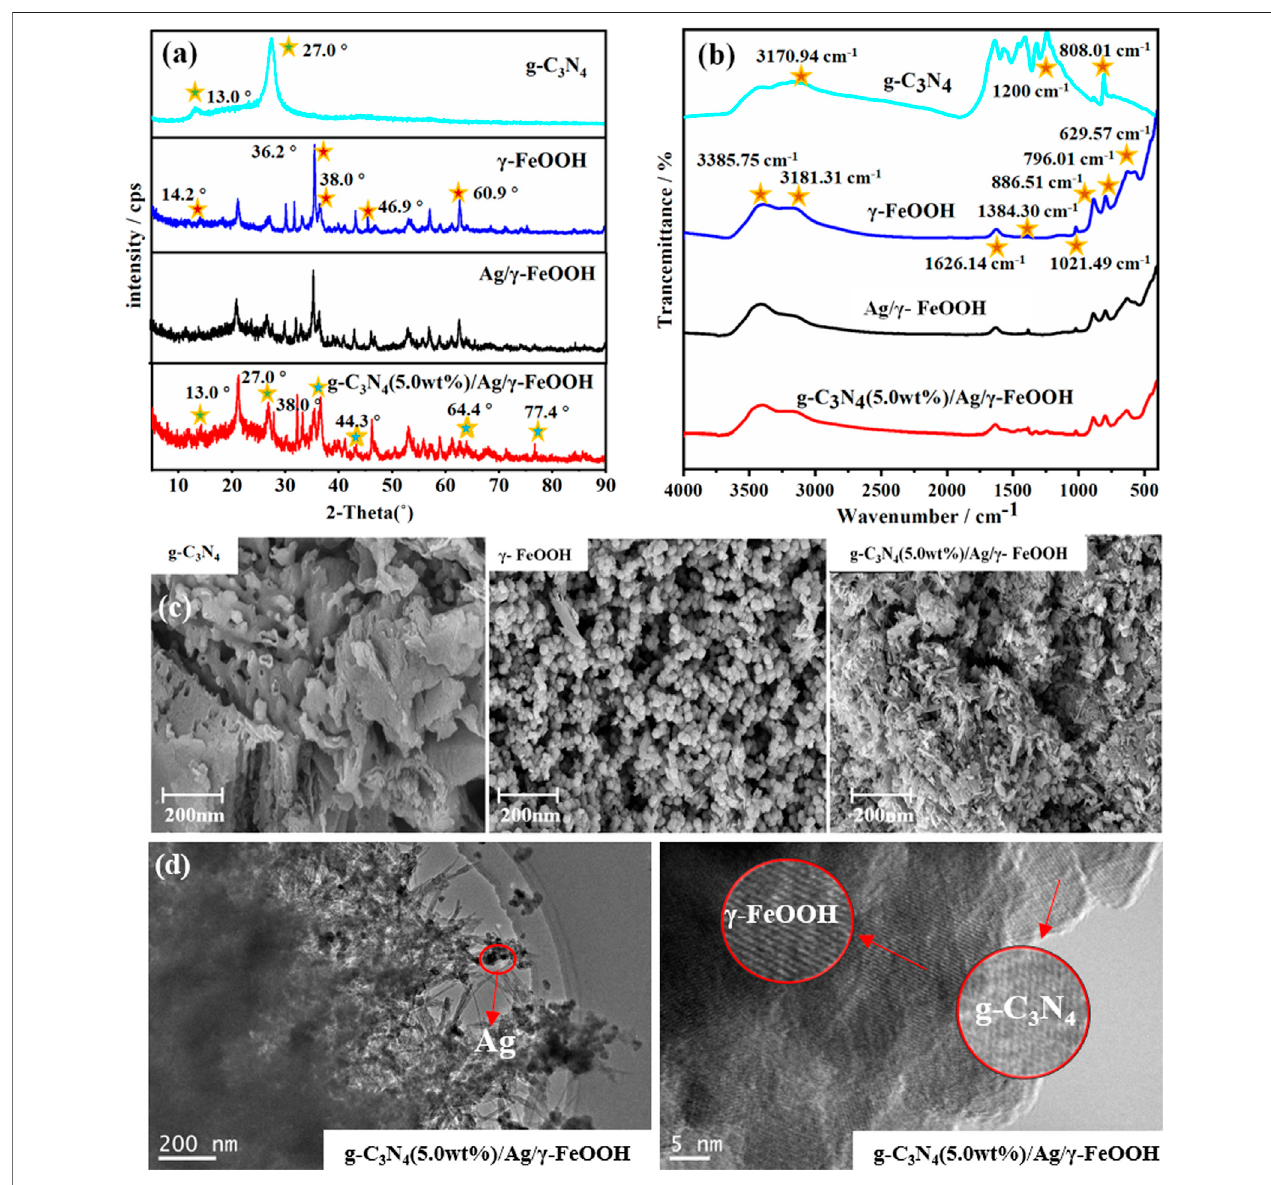
FIGURE 2 | (A) XRD patterns of the catalysts, (B) FT-IR spectrograms of the catalysts, (C) SEM of g-C 3 N 4 , γ -FeOOH and g-C 3 N 4 (5 wt%)/Ag/ γ -FeOOH, (D) HRTEM characterization of